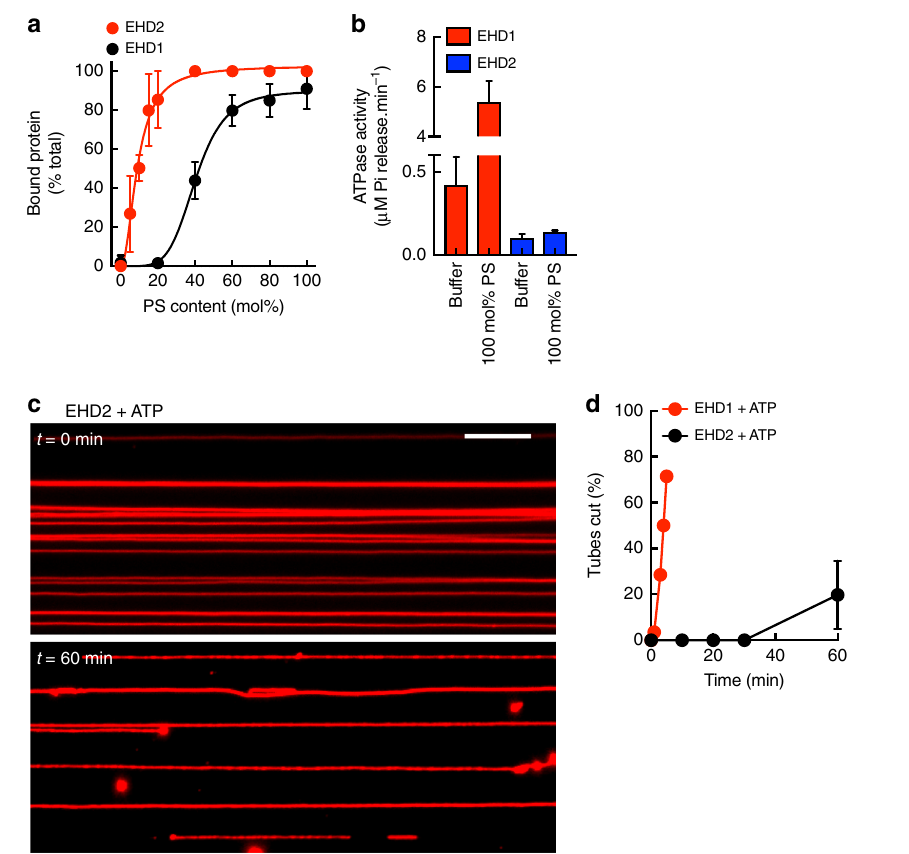
Fig. 10 Functional differences between EHD2 and EHD1. a Bound fraction of EHD2 with liposomes of increasing PS content (mean ± SD, N = 3). Data for EHD1 are shown for comparison. b ATPase activity of EHD2 with and without PS liposomes (mean ± SD, N = 3). Data for EHD1 are shown for comparison. c Frames from representative movie showing EHD2 added to templates with ATP acquired at the indicated time periods. Scale bar = 10 μ m. d Plot showing the number of tubes cut (as percentage of the total tubes analyzed) with the indicated proteins. Data represent the mean ±